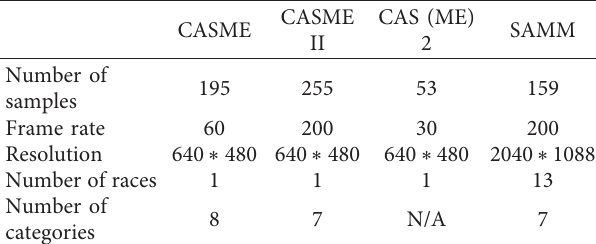
Table 1: Existing database of spontaneous